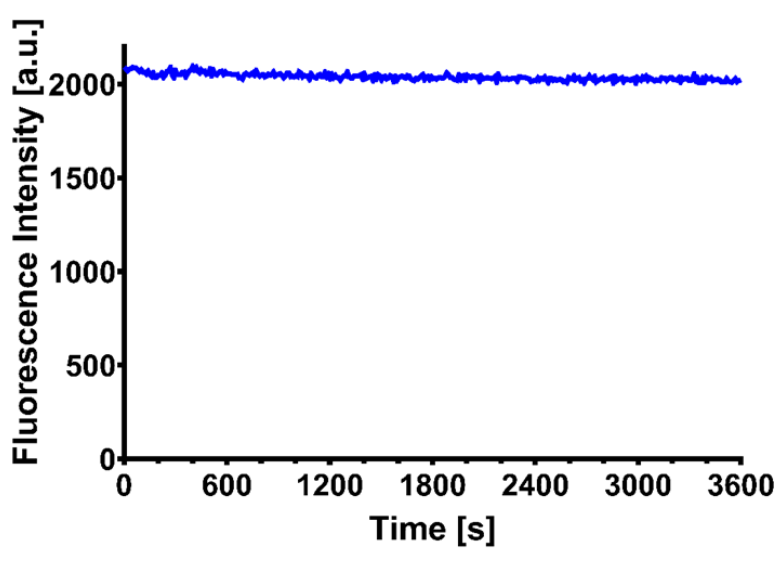
Figure 4. Assessment of CQDs fluorescence intensity under continuous irradiation for 1 h.